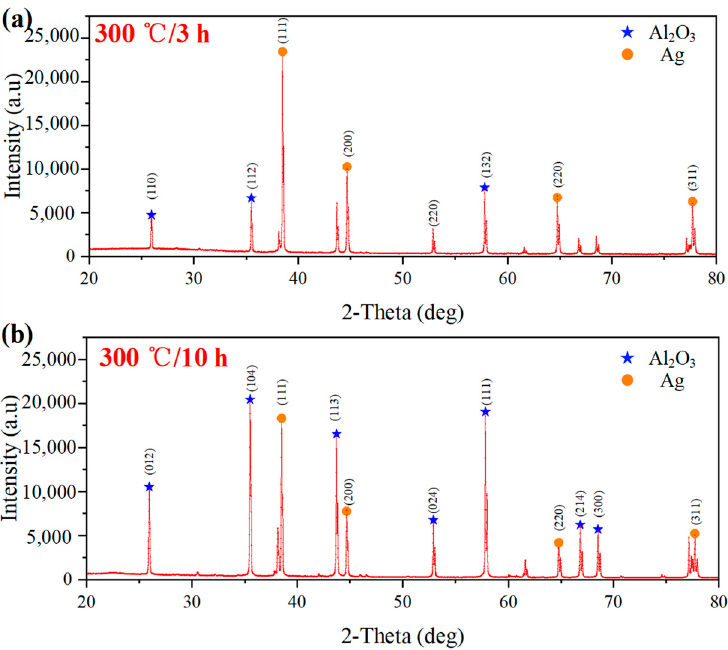
Figure 4. ( a ) XRD of a wireless LC conformal temperature sensor at 𝟑𝟎𝟎 ℃ for 3 h; ( b ) XRD of a wireless LC conformal temperature sensor at 𝟑𝟎𝟎 ℃ for 10 h.